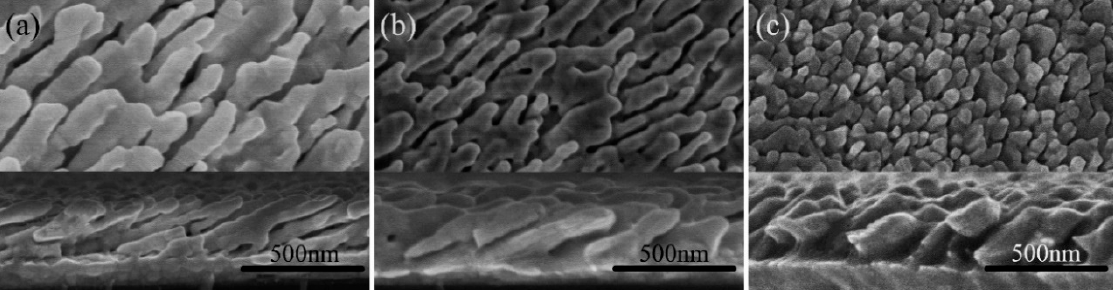
Figure 9. The SEM images of AuNRs deposited at di ff erent deposition rate R: ( a ) R = 1 Å / s, ( b ) R = 2 Å / s,